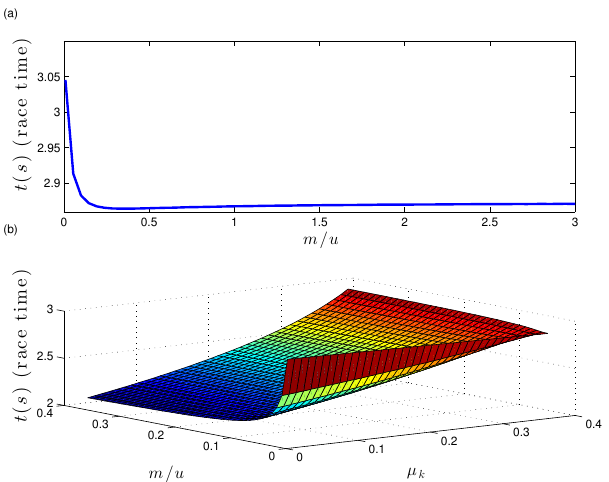
Figure 10. The uncertainty magnification factor as we change the normalized cross section area (dashed line), mass (stars), friction coe ffi cient (circles), outer wheel radius (dotted) and inner wheel ra- dius (solid line) with parameters given in Table